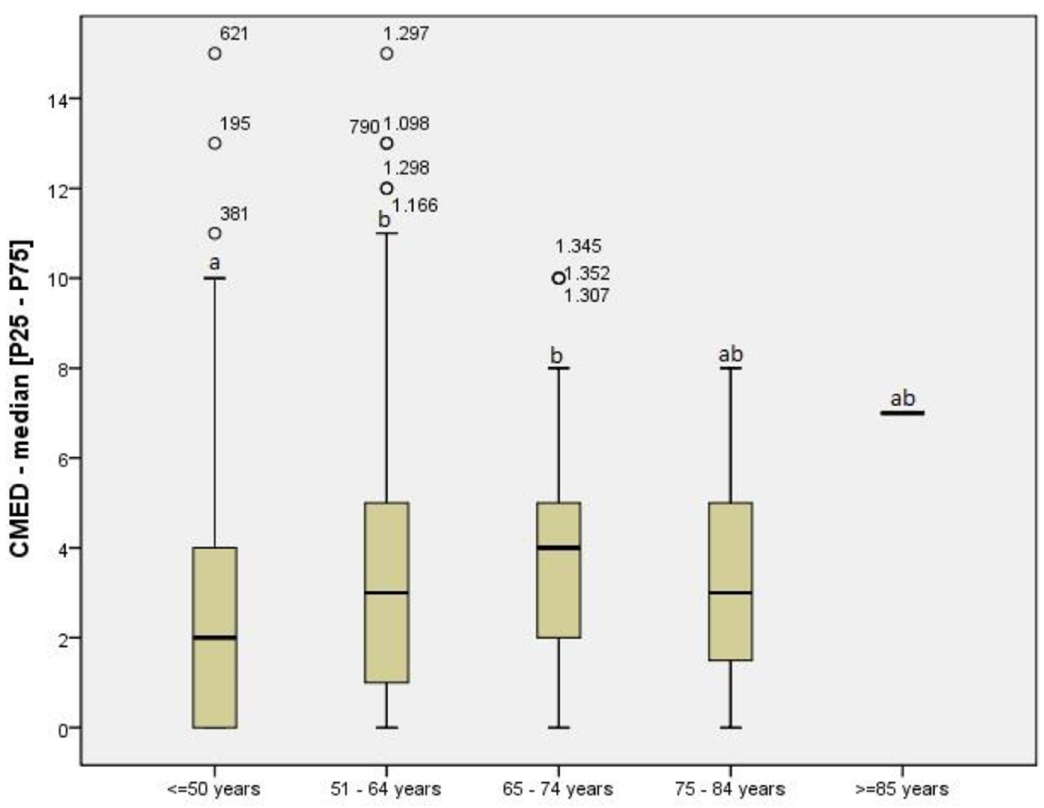
Fig 2. Comedications according to age group. Legend: CMED: comedications; P25-P75: interquartile range (percentiles 25th - 75th); Kruskal-Wallis test (Dunn post hoc): p � 0.0001. Significance set at 5% for all analysis. Different letters (ab) indicate Statistical